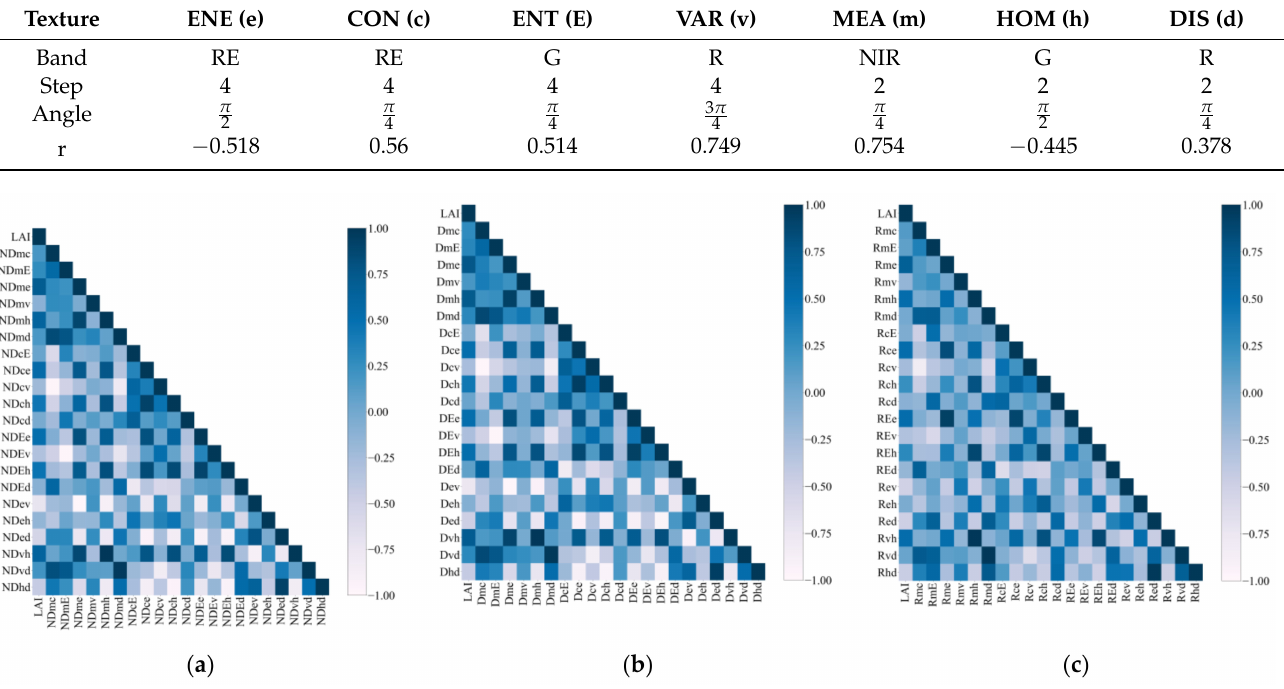
Table 5. The optimal parameter combination of texture features extracted based on GLCM.